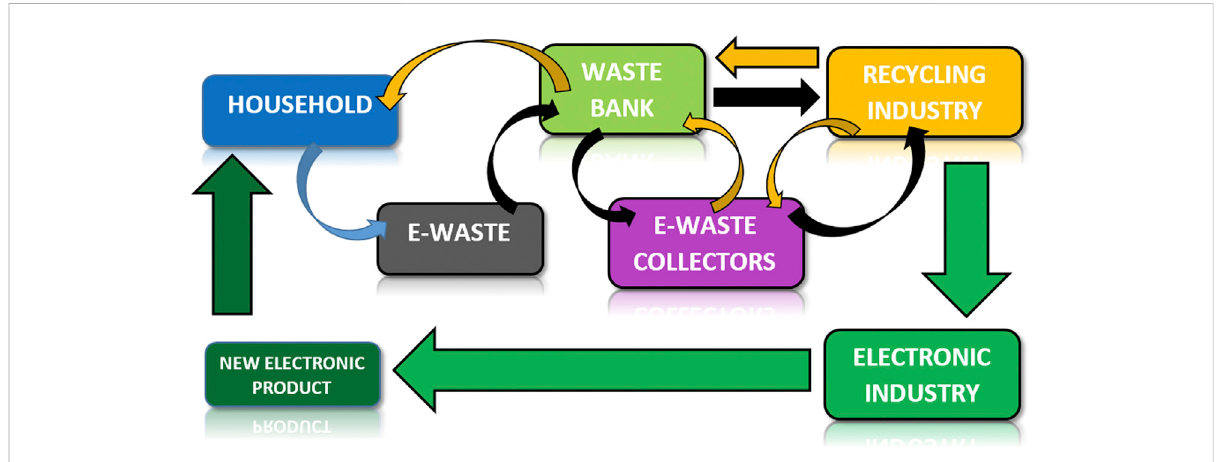
FIGURE 5 Conceptual model of circular economy implementation through waste bank.